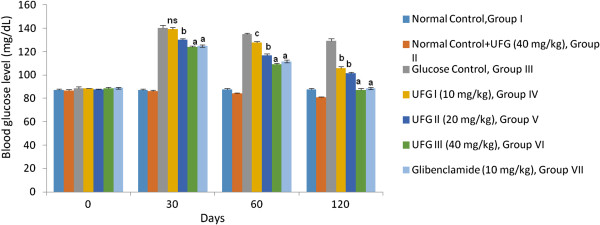
Effect of umbelliferone β-D-galactopyranoside on fasting plasma glucose on oral glucose tolerance test at different concentrations on STZ induced diabetic rats, compared to diabetic control group rats; values are mean ± SEM; n = 6;
c
P < 0.05;
b
P < 0.01;
a
P < 0.001; P > 0.05 is considered as non-significant (ns).